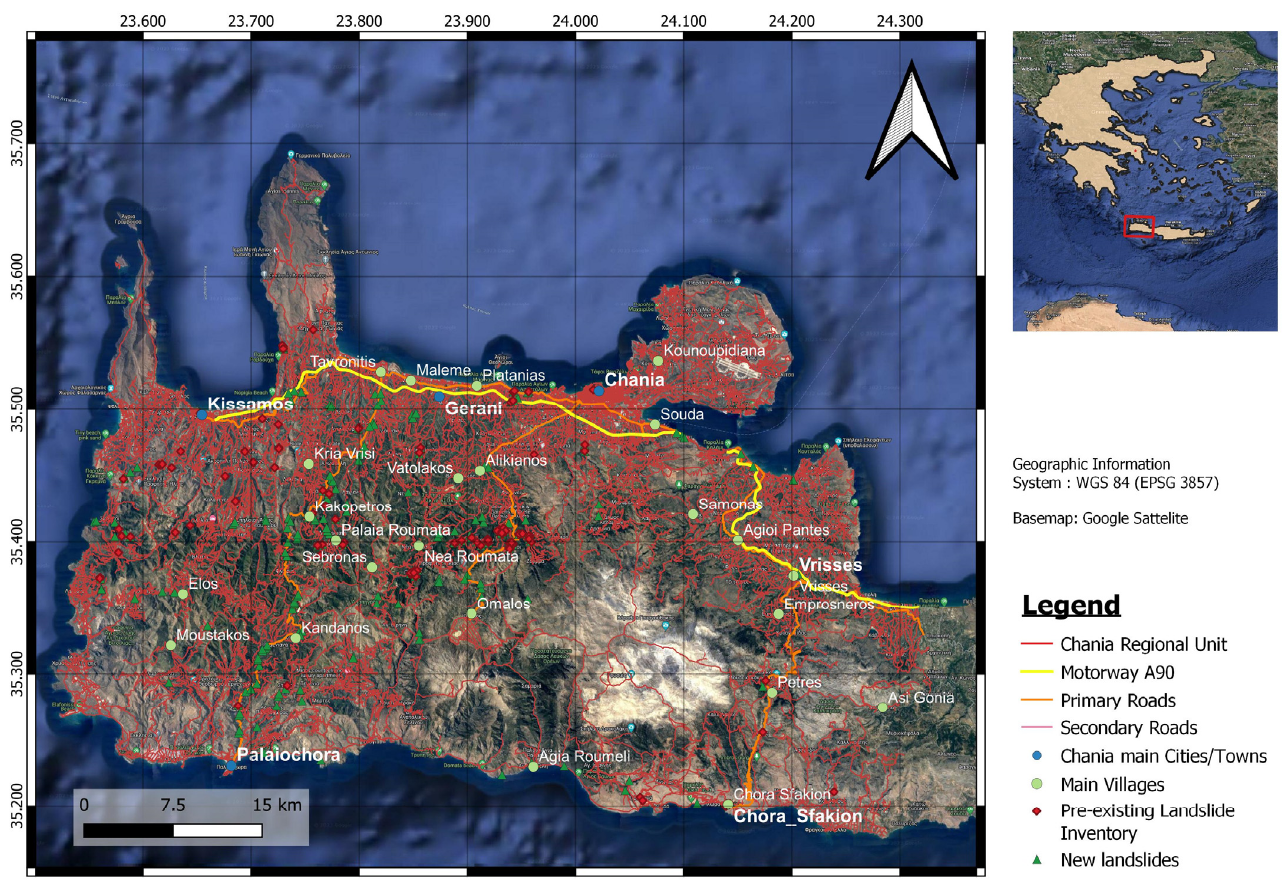
Figure 8. Landslide inventory map of the road network of Chania regional unit.